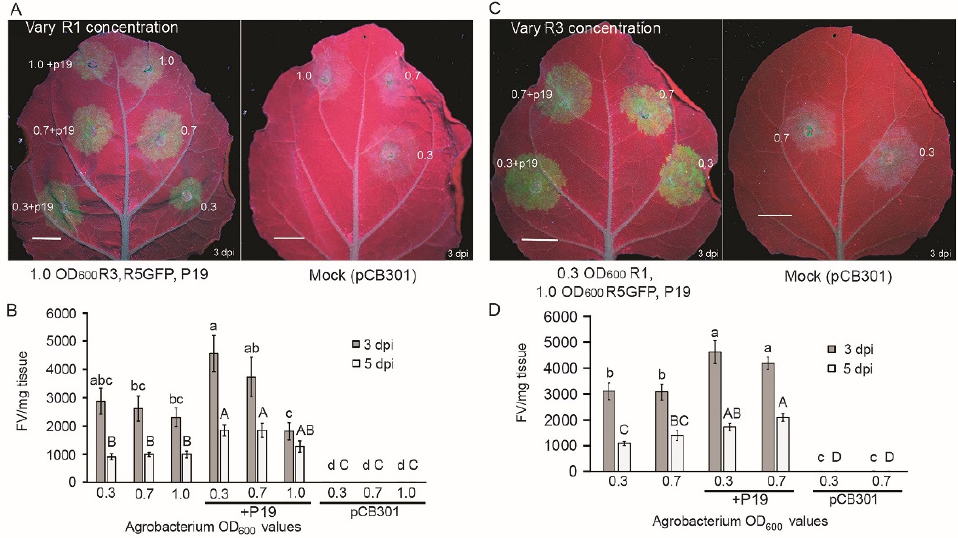
Figure 2. Optimizing Agrobacterium concentrations for delivery of RRV constructs. ( A ) A. tumefaciens harboring R1 were concentrated to 1.0, 0.7, and 0.3 OD 600 and co-delivered with R3, R5-GFP, and p19 at concentrations of 1.0 OD 600 . Images show GFP fluorescence under a handheld UV lamp at 3 dpi. Scale bars represent 1 cm. ( B ) Bar graph displaying the average FV/mg tissue ( n = 6) at 3 and 5 dpi obtained in one representative experiment. The lines through the bars represent standard error of the mean. The concentrations of A. tumefaciens cultures delivering R1 were 1.0, 0.7, and 0.3 OD 600 . Multiple comparisons of the means were performed using Tukey’s HSD ( p < 0.05) and statistical relatedness is represented by letters next to each standard error bar. Values with the lowercase letter represent statistical analysis at 3 dpi and uppercase letter represent statistical analysis at 5 dpi. Bars with the same letters at 3 dpi or 5 dpi are not statistically different. ( C ) A. tumefaciens harboring agRNA3 were concentrated to 0.7 and 0.3 OD 600 and co-delivered with 0.3 OD 600 of agRNA1 and 1.0 OD 600 of R5-GFP and p19. ( D ) Bar graph displaying the average FV/mg fresh weight tissue ( n = 6) at 3 and 5 dpi obtained in one representative experiment using R3 at 0.7 and 0.3 OD 600. The lower-case letters at 3 dpi and the uppercase letters at 5 dpi indicate the significance levels obtained using Tukey’s HSD ( p < 0.05), and lines through the bars represent standard error of the mean. Values with the same letter are not statistically